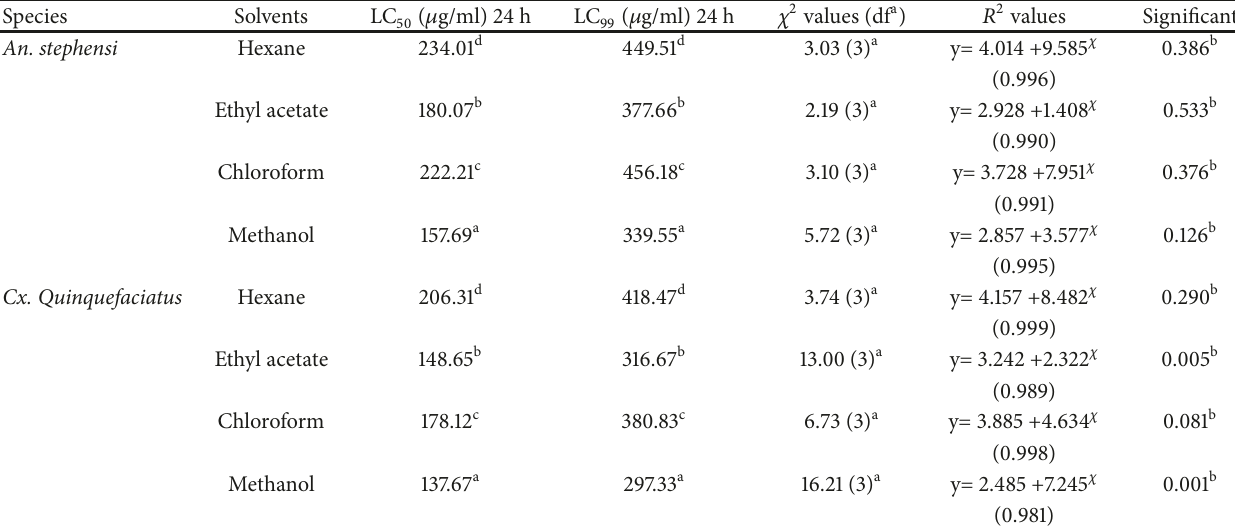
Table 2: Larvicidal activity of E. variegata extracts against An. stephensi and Cx. quinquefasciatus .